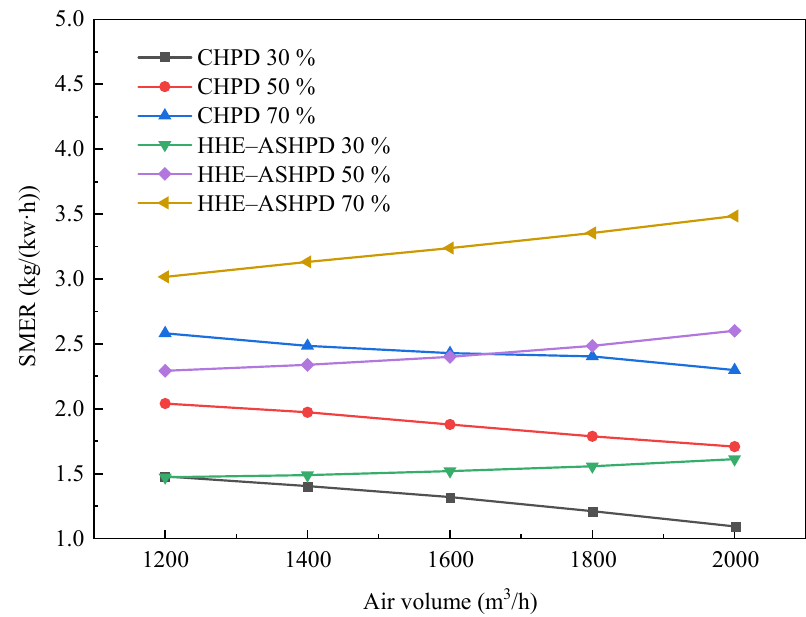
Figure 11. Effects of air volume and relative humidity on the two circulation modes.